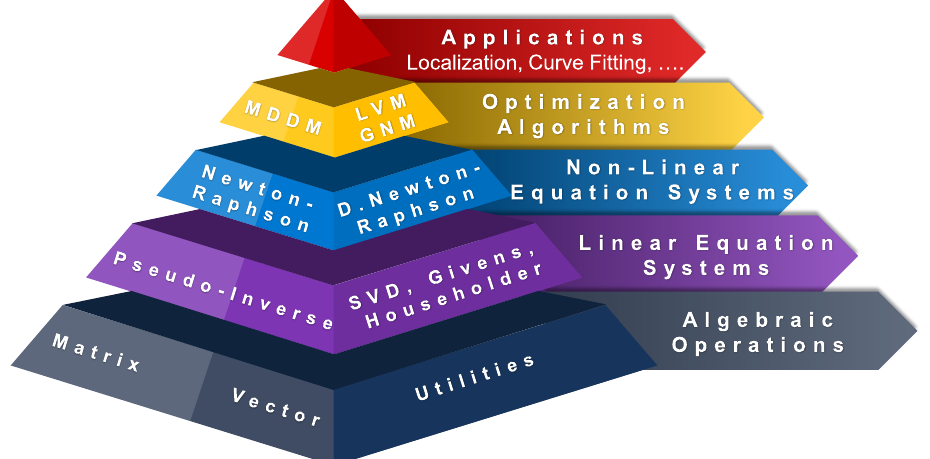
Figure 1. Architecture of the RcdMathLib. SVD, Singular Value Decomposition. D. Newton-Raphson, Damped Newton-Raphson. LVM, Levenberg–Marquardt Method. GNM, Gauss–Newton Method. MDDM, Multipath Distance Detection and